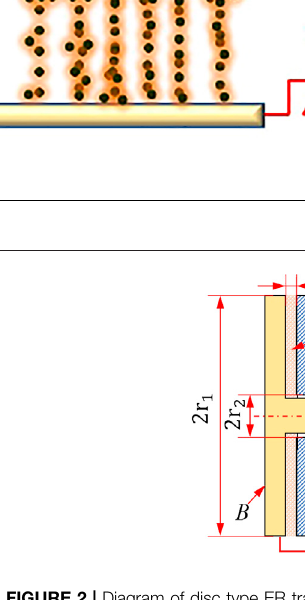
Figure 1 ; Under low strain rate, ER fl uids have viscoelastic